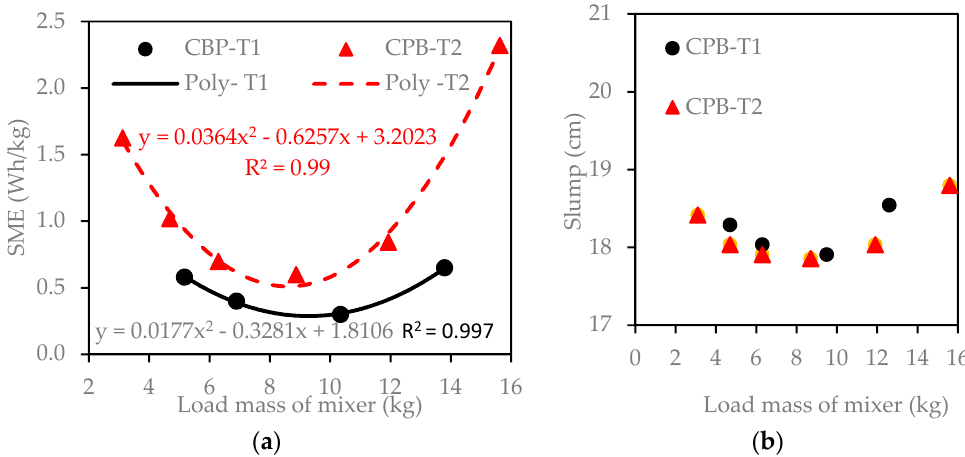
Figure 8. Influence of mixer load mass on: ( a ) SME and ( b ) consistency for CPB-T1 (M09–M12) and CPB-T2 (M21–M26) with the Omcan SP300AT mixer rotating at 166 rpm for 5 min.